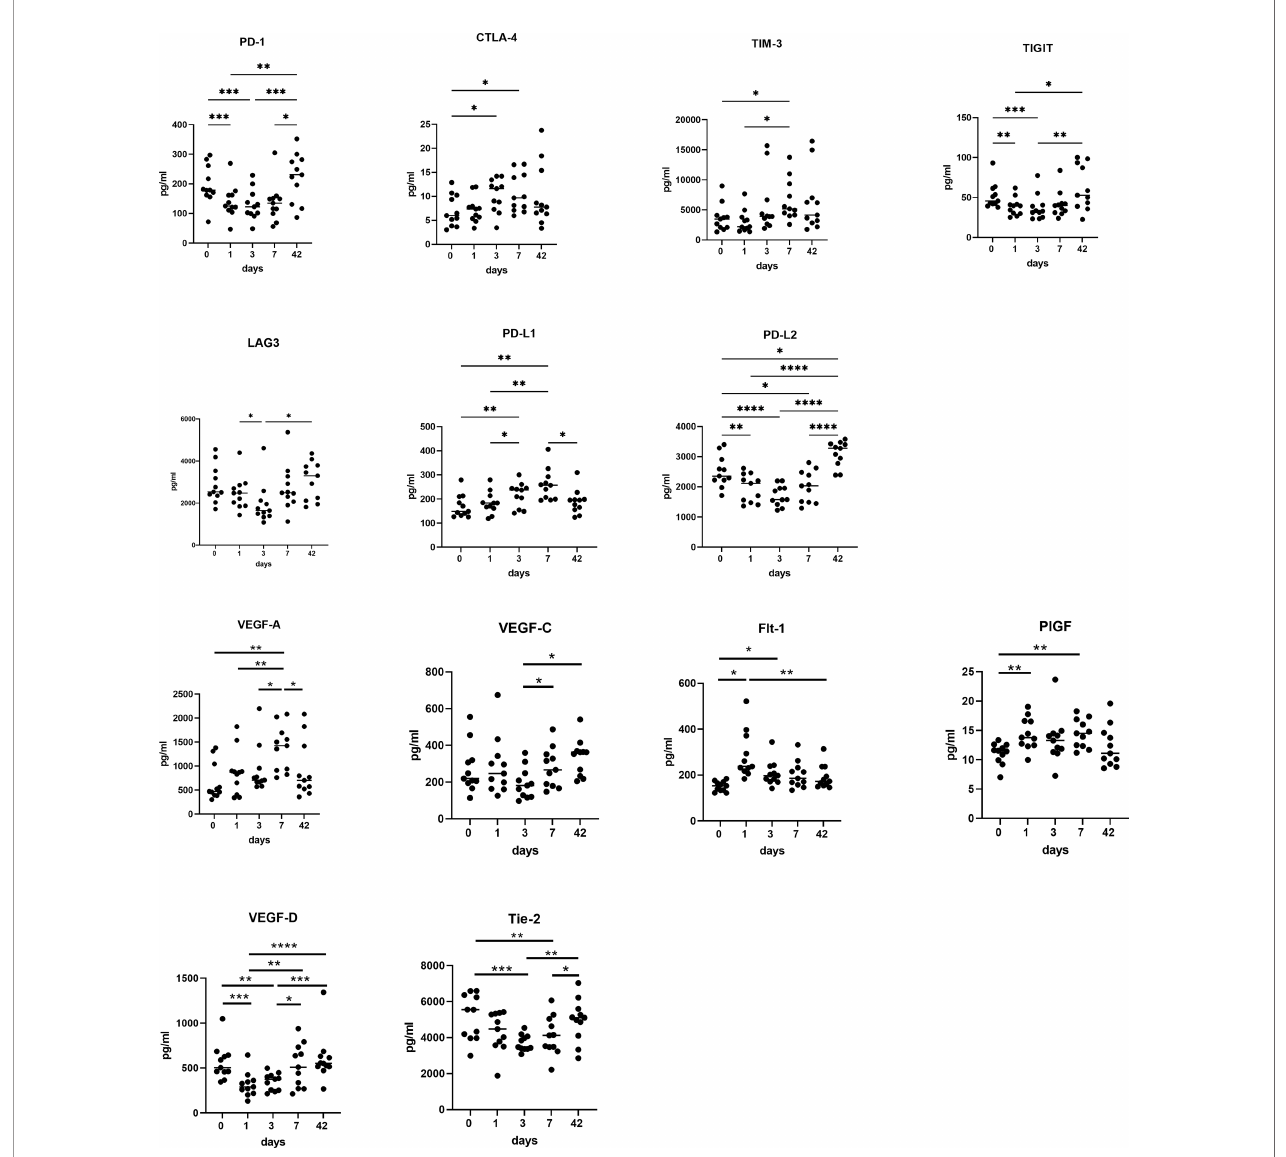
FIGURE 6 | Circulating levels of pro-angiogenic and pro-metastatic factors increase in the immediate post-operative setting. POD 0, 1, 3 and 7 and week 6 serums from OAC patients (n=11) were screened for a panel of soluble inhibitory immune checkpoints PD-1, CTLA-4, TIM-3, TIGIT, LAG-3, PD-L1 and PD-L2 and a panel of soluble pro-angiogenic and pro-metastatic mediators VEGF-A, VEGF-C, PIGF, FLT-1, VEGF-D and Tie-2 by ELISA. *p<0.05, **p<0.01, ***p<0.001,